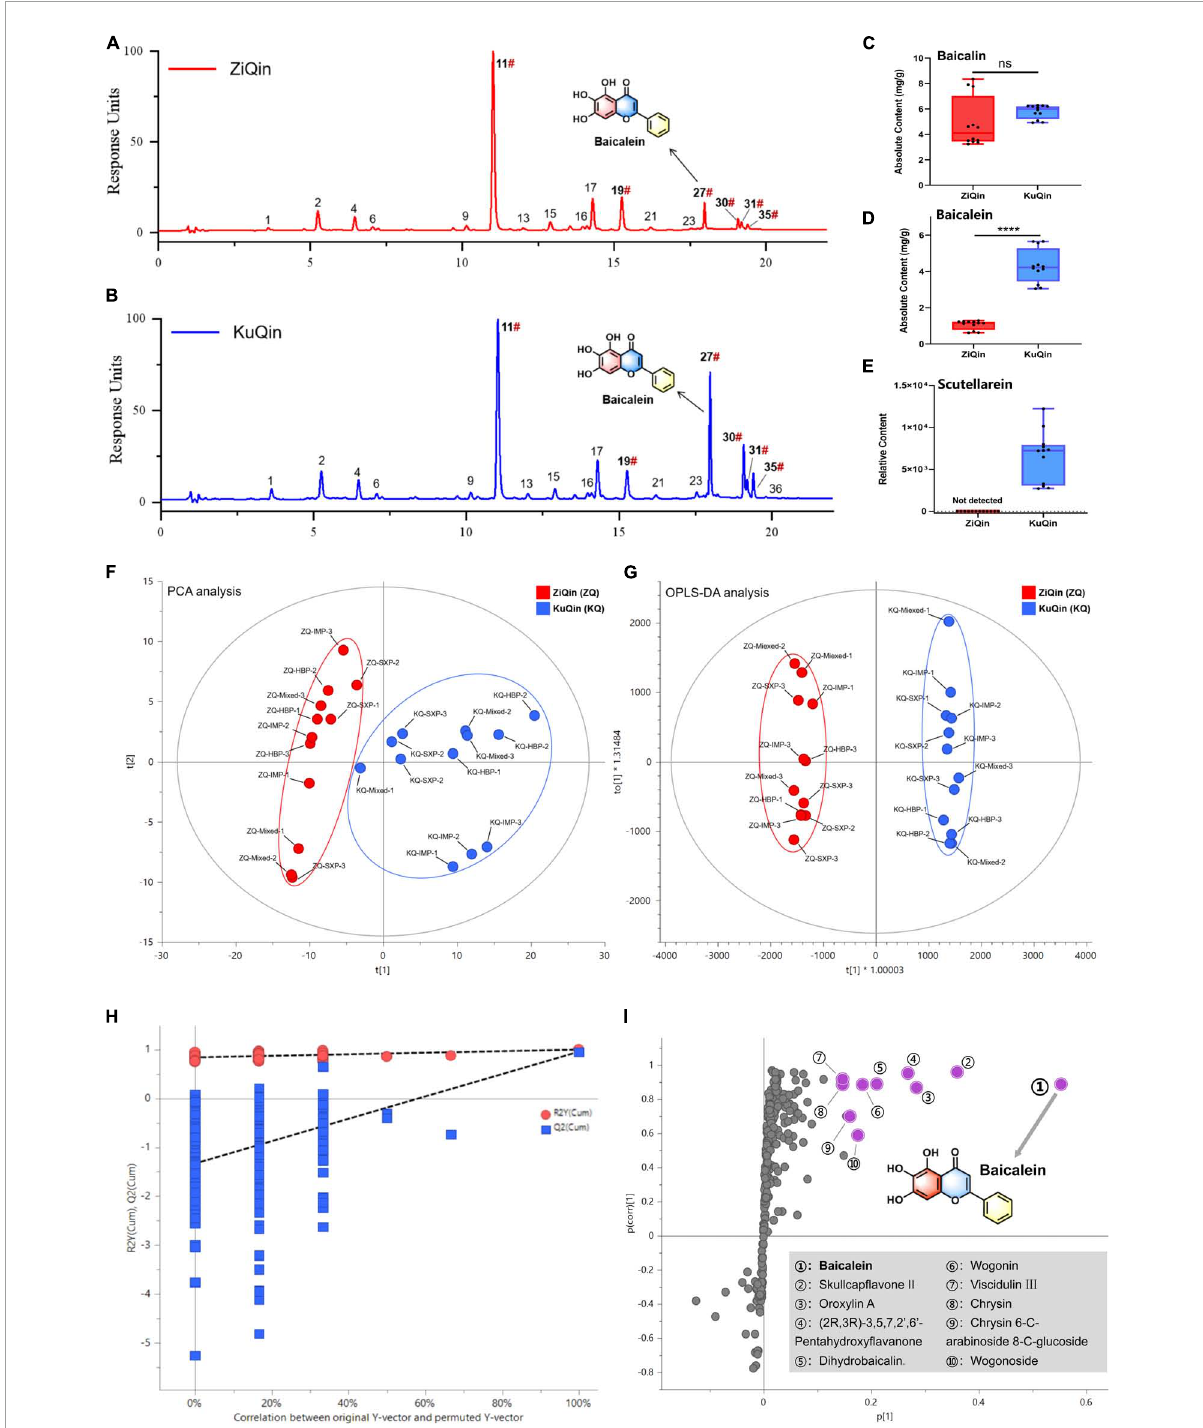
FIGURE10 Chemical comparison between ZiQin and KuQin. (A,B) UHPLC-UV chromatograms of ZiQin and KuQin extract under UV wavelength of 270 nm. The label of “#” indicated that compounds were confirmed by reference standards. (C,D) Quantitative analysis of baicalin and baicalein in ZiQin (red) and KuQin (blue) extracts by UHPLC-UV with an external standard method, respectively. (E) The relative content of scutellarein under MS detection. (F,G) The PCA analysis and OPLS-DA analysis between ZiQin and KuQin. (H) Permutation test ( n = 200) demonstrated no overfitting in the OPLS-DA model. (I) S-plot diagram from the OPLS-DA model between ZiQin and KuQin. The points highlighted in purple implied the compounds with significantly higher content in KuQin than those in ZiQin (HBP, Hebei province; IMP, Inner Monglia Autonomous Region; SXP, Shanxi province; Mixed, All samples in the same category were mixed in equal